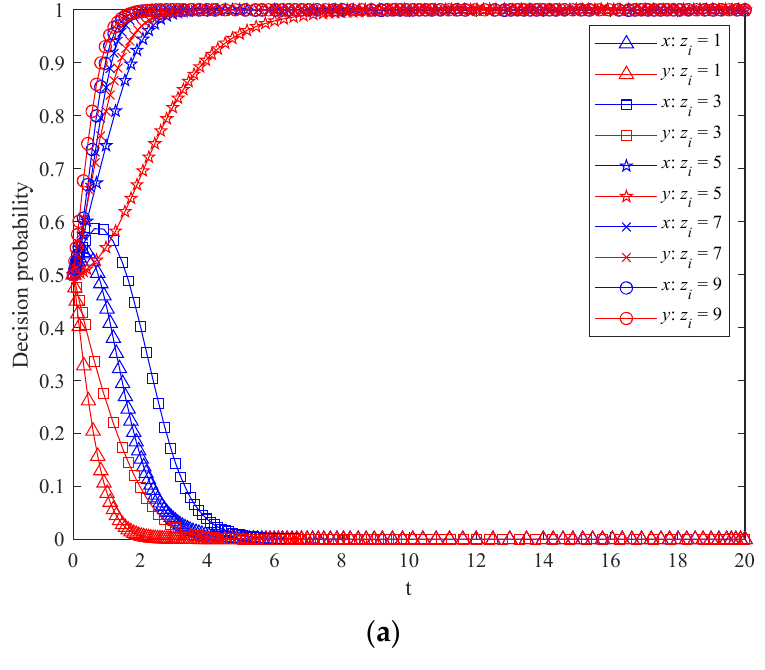
Figure 8. The dynamic diagram of SMEs and LFs.